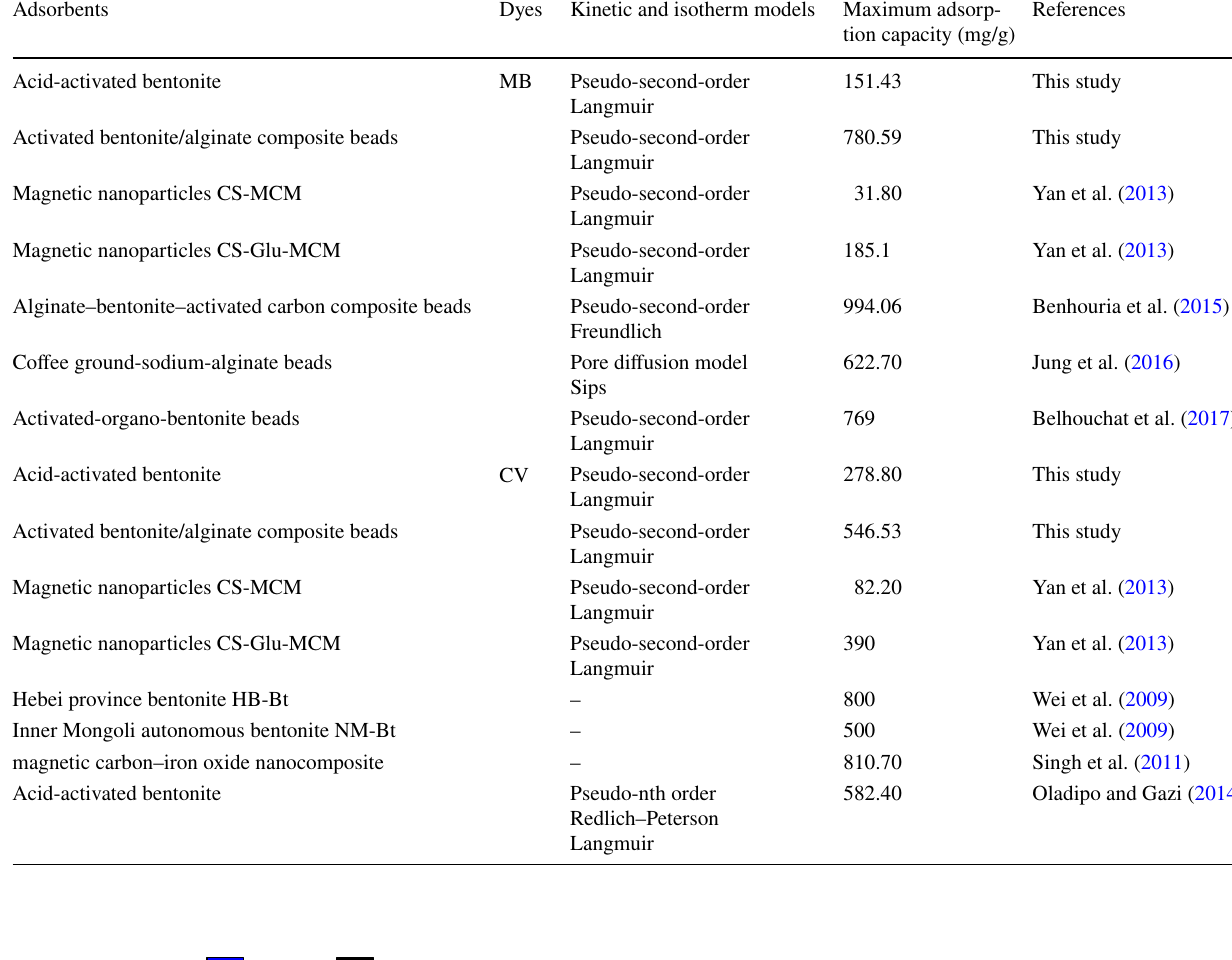
Table 5 Comparison of dyes adsorption amounts onto various adsorbents Adsorbents